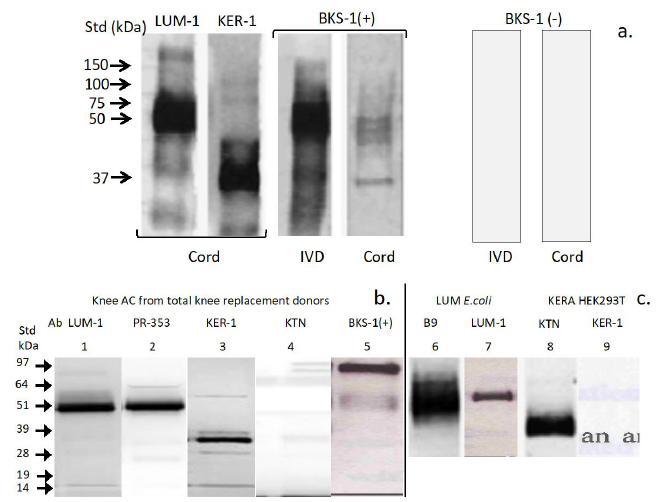
Figure 2. Western blotting validation of the specificity of the KER-1 and LUM-1 antibodies and comparison of the KS species identified by BKS-1 with keratanase pre-digestion (+) or without keratanase digestion (-) in extracts of 4 month rat spinal tissues ( a ), human articular cartilage, ( b ) and positive identification of recombinant lumican (LUM E .coli ) and keratocan (KERA HEK 293T) standard proteins ( c ). The PG species detected in extracts of human articular cartilage (AC) by a number of commercial and gifted lumican (PR-353; B9, Santa Cruz cat # sc-166871) and keratocan (KTN, abcam cat # ab113115) were also compared with those identified by LUM-1 and KER-1 ( b ). All samples were predigested with keratanase-I. Cells 2020 , 8 , x FOR PEER REVIEW